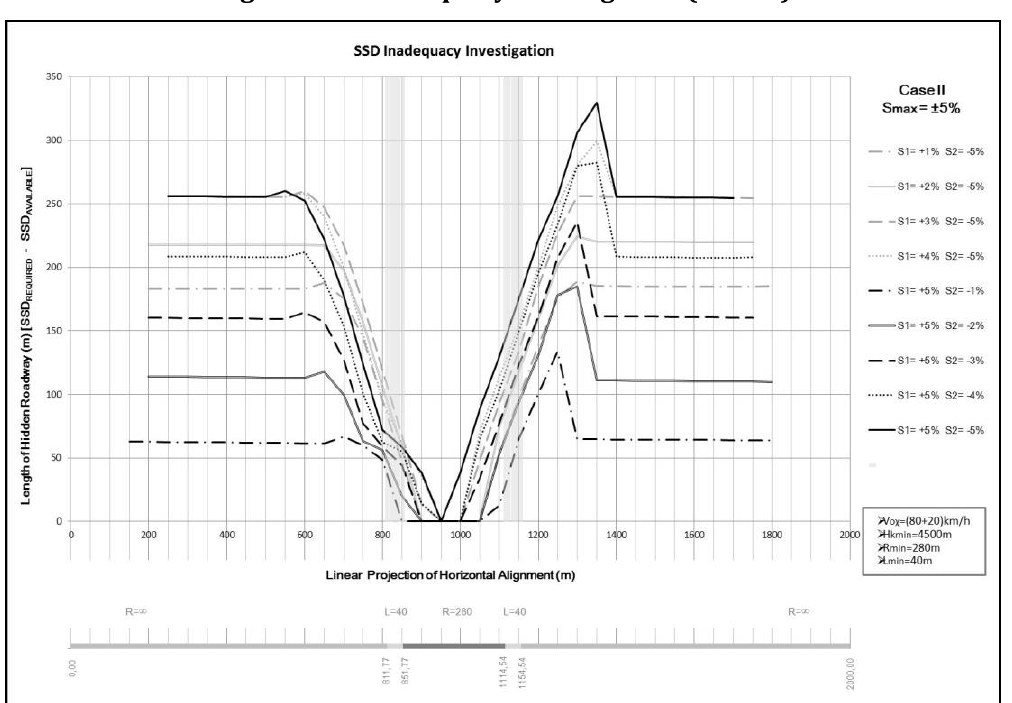
Figure 4: SSD adequacy investigation (Case